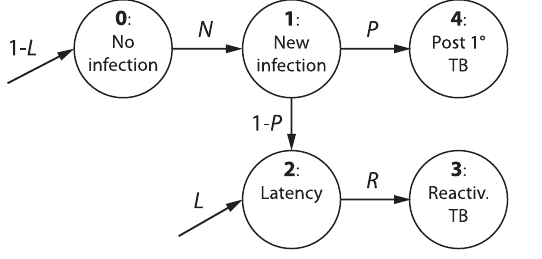
Figure 2. Toy Markov chain. From the state A there is a potential flux of probability at rate w A ? B toward the state B , hence we expect that, after a proper amount of time, a fraction of the probability p will be drained from A to B . The same holds for the situation linking C to B . After an infinite time the probability of having the patient in the state C is one, while it is zero for the states A , B